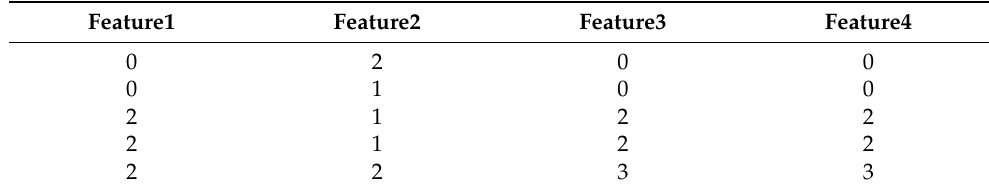
Table 3. Standardized data obtained after applying the standardize_categorical_cols to Table 2.